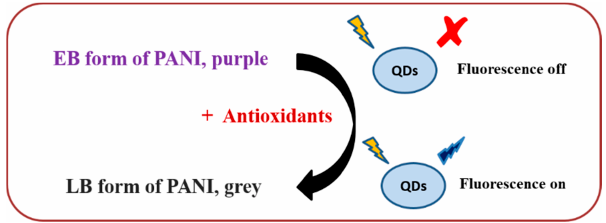
Figure 4. Scheme of the fluorescent turn-on sensing strategy for antioxidants.